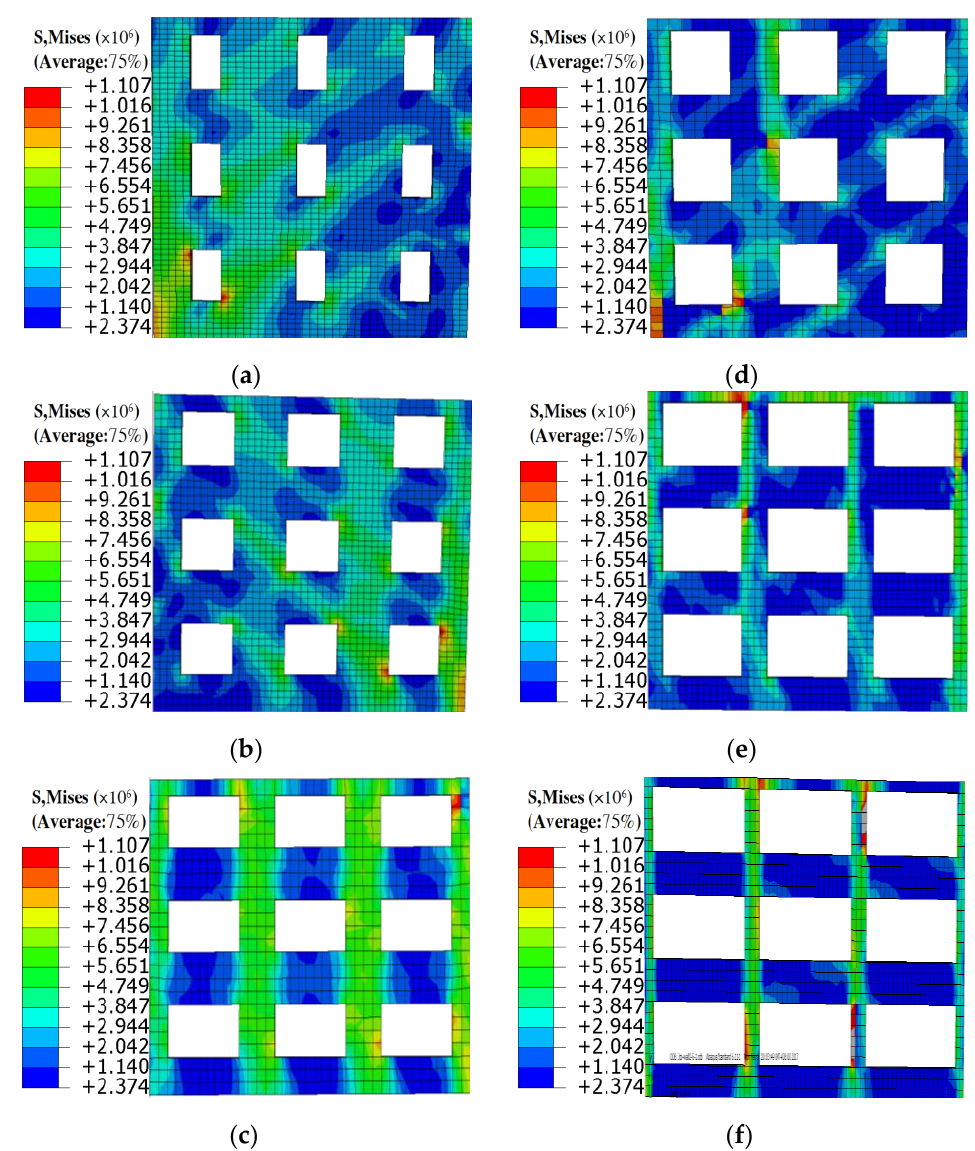
Figure 5. Comparison of simulation results of partial models: ( a ) M2-1 ( η = 1.0, ρ = 0.5); ( b ) M2-4 ( η = 1.0, ρ = 1.25); ( c ) M2-7 ( η = 1.0, ρ = 2.0); ( d ) M3-1 ( η = 1.8, ρ = 0.5); ( e ) M3-4 ( η = 1.8, ρ = 1.25); ( f ) M3-7 ( η = 1.8, ρ = 2.0).